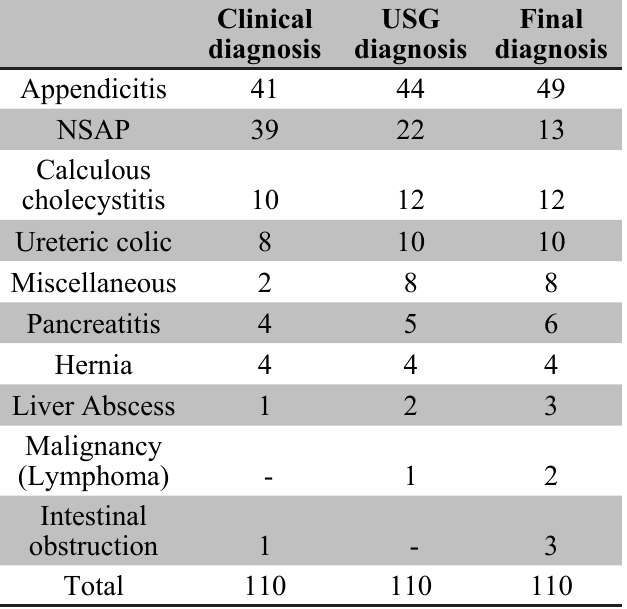
Table 3. Frequency comparison of causes of acute abdomen by different modalities (N=110).